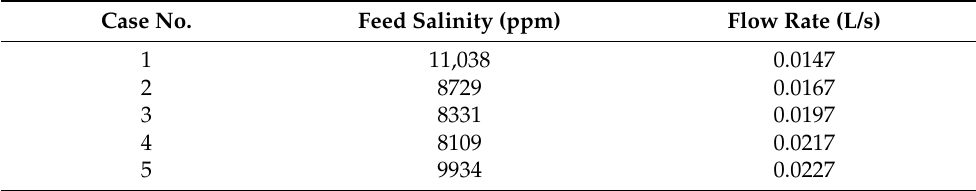
Table 2. Different CDI inlet feed conditions for analysis in this study. Case No.